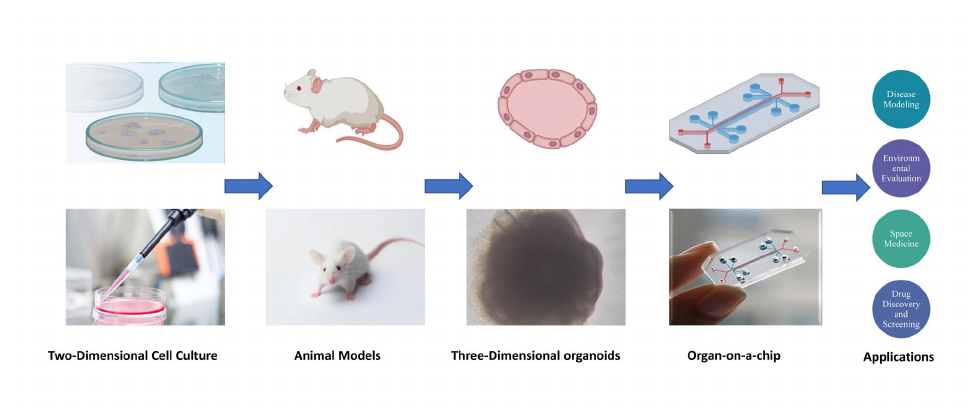
Figure 1. Evolution of the models and the application of OOC. From two-dimensional cell cultures to animal models and three-dimensional organoids to OOC, technology has evolved to allow more options for applications such as disease models and drug